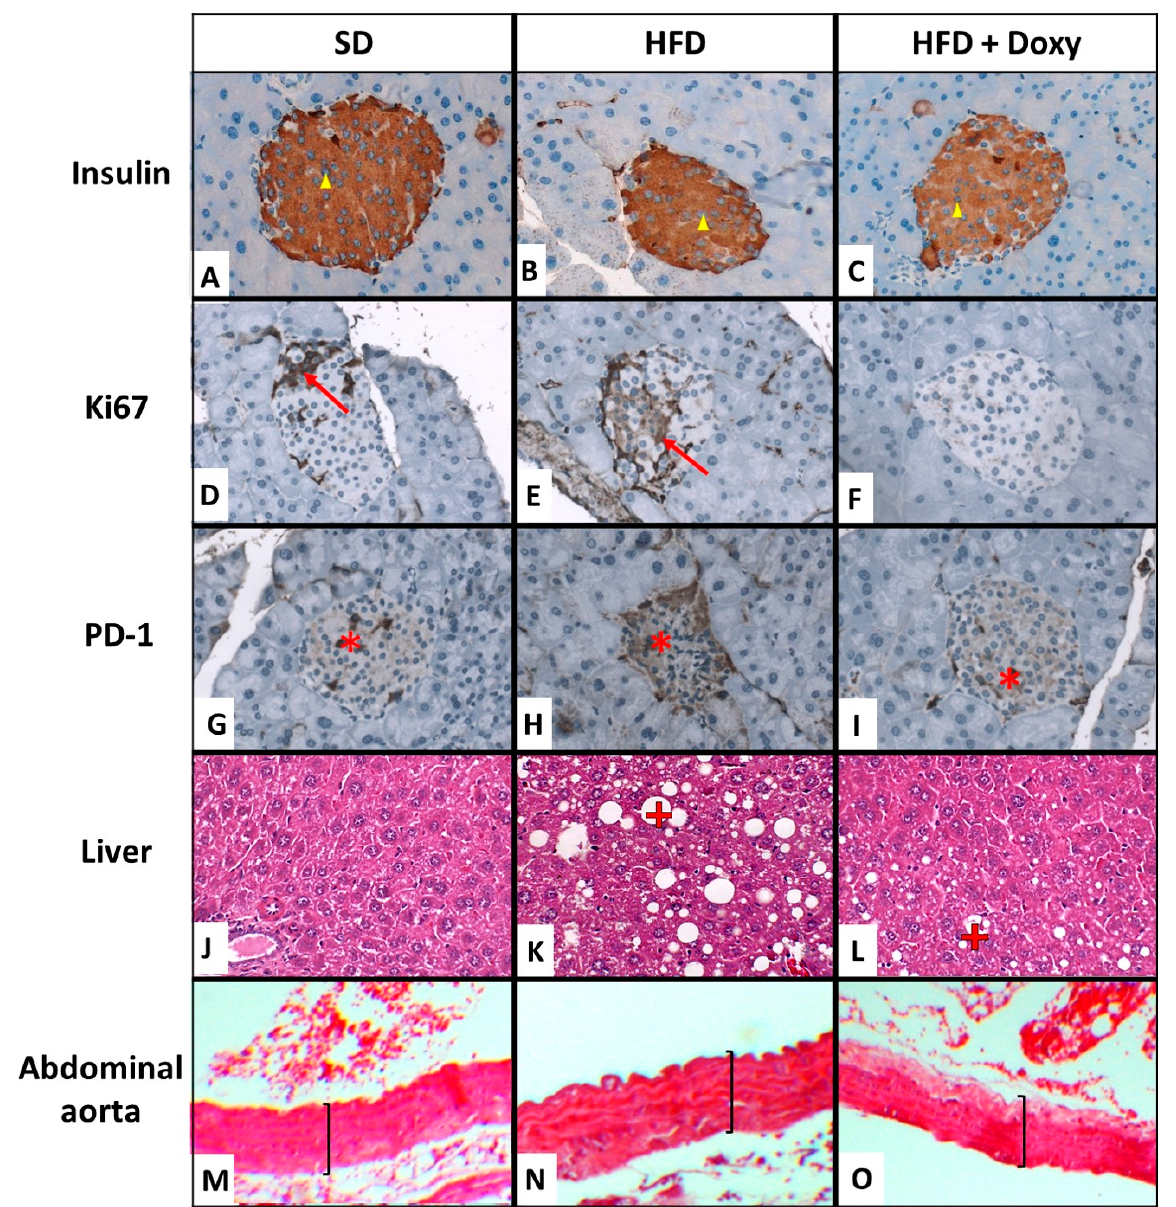
Figure 1. Histological sections of pancreatic tissue, liver, and abdominal aorta in the SD (standard diet), HFD (high-fat diet), and HDF + Doxy (high-fat diet + doxycycline) groups. ( A – I ): Islets of Langerhans from mice with SD ( A , D , G ), HFD ( B , E , H ), and HFD + Doxy ( C , F , I ) at the end of the experiment. Sections were immunostained for insulin ( A – C ), Ki67 ( D – F ), or PD-1 ( G – I ). ( A , C ) showed no statistical difference in the number of conserved beta cells (arrowhead) with insulin expression (brown-brown), ( p = 0.873). ( B ) shows smaller pancreatic islets and fewer β cells. ( D – F) were immunostained with Ki67. ( D , E ) show a positive reaction to the Ki67 marker (red arrows). ( E ) shows greater cell proliferation positivity compared to ( D , F ) ( p < 0.05, for both comparisons). ( F ) shows a negative response to the Ki67 marker. G-I show islets immunostained with the PD-1 marker. ( G , I ) show low expression of the apoptosis marker with respect to ( H ) ( ∗ ). ( J – L ) show H&E-stained (X200) sections of liver tissue. ( J ) shows normal liver tissue. ( K , L ) show fatty deposits (+) and moderate to mild inflammation. ( M – O ) show H&E-stained (X50) sections of the abdominal aorta. ( N ) presents a greater thickness of the aorta (]) compared to ( M , O ). Regarding ( M , O ), there is no difference in the thickness of the aorta wall.